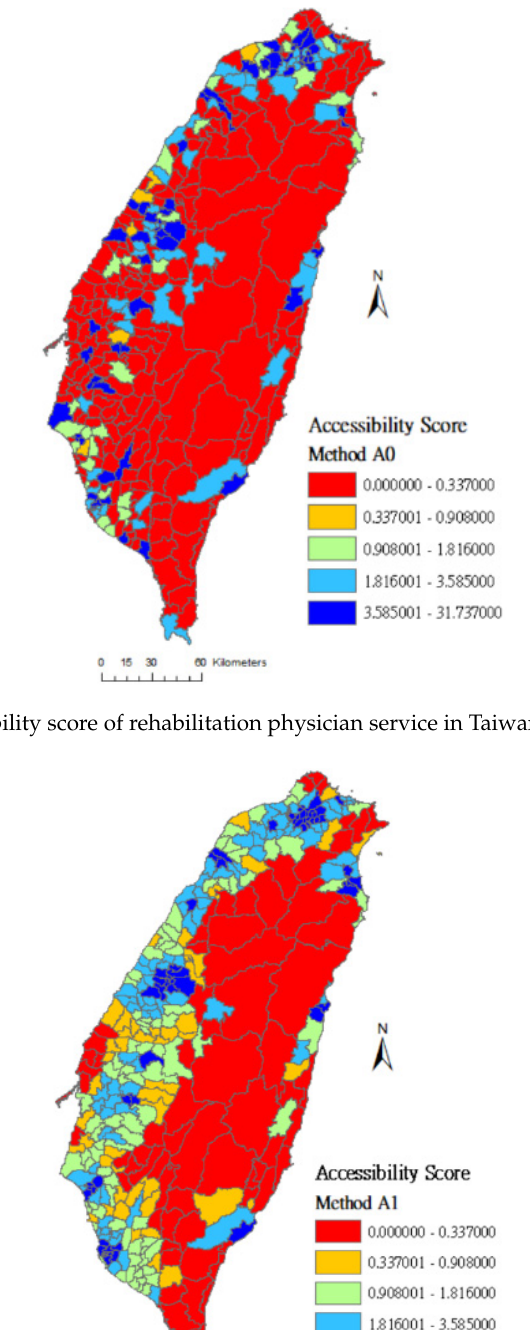
Figure 3. Accessibility score of rehabilitation physician service in Taiwan using method A4. Based on the three-step floating catchment area method, Table 7 shows the results of assessments on inequality in resource accessibility with methods A2–A4. According to the calculation results of the three methods, 50% of the medical resources in towns had low accessibilities (negative value of “median value minus mean value”) in Taitung County and Hualien County. When we compared the inequality in resource accessibilities of counties/cities with the Gini coefficient, the value of Taitung County was close to the critical value of high inequality.